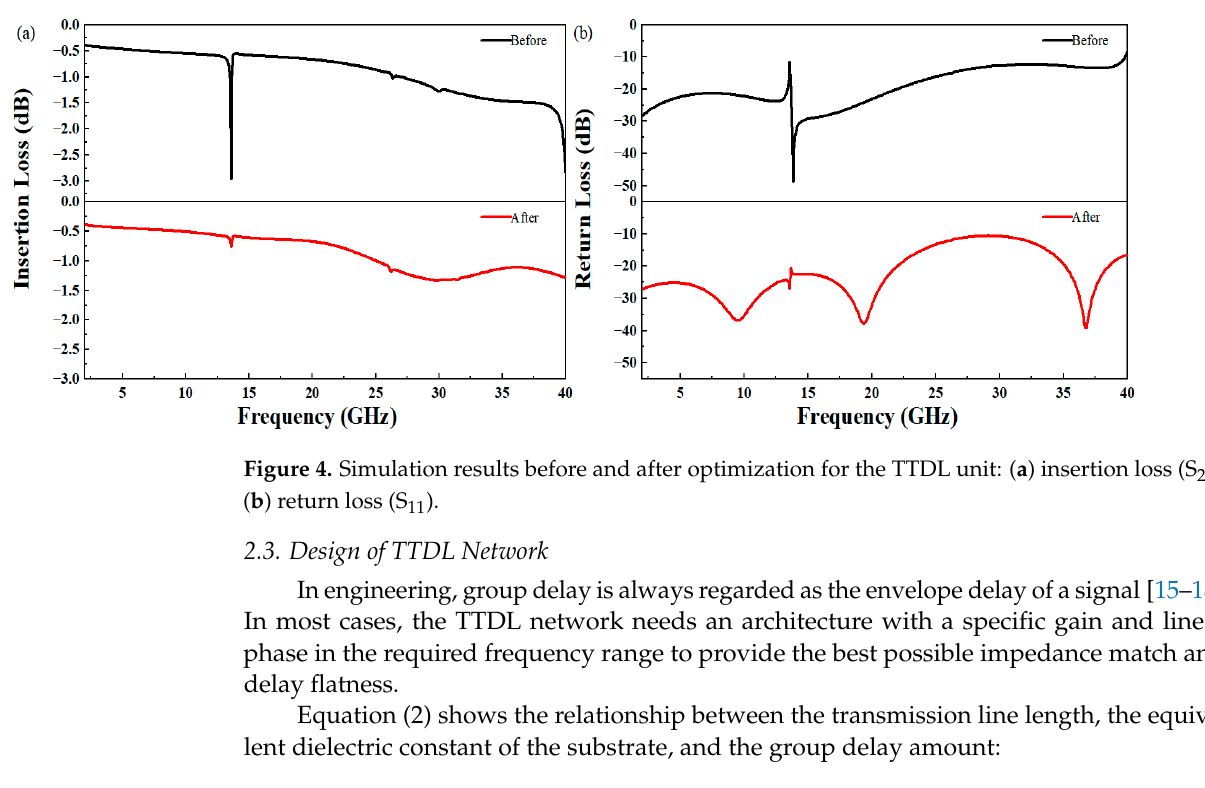
Figure 4. Simulation results before and after optimization for the TTDL unit: ( a ) insertion loss (S 21 ), ( b ) return loss (S 11 ).